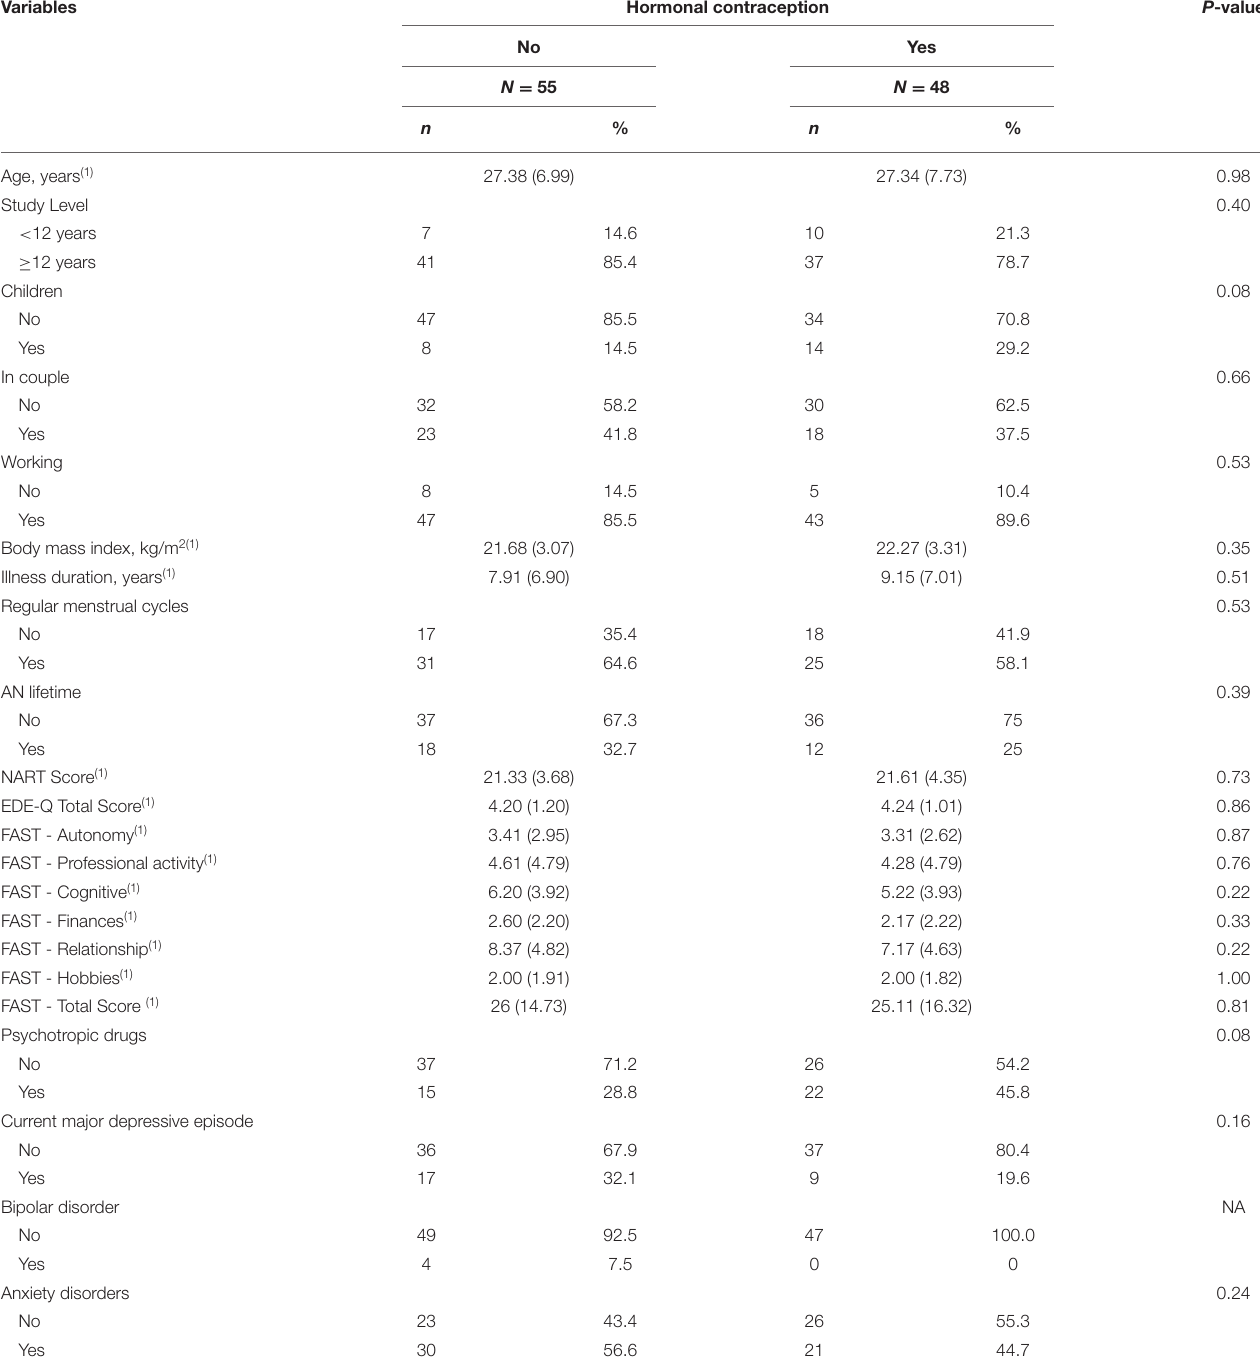
TABLE 1 | Association between hormonal contraception and sociodemographic and clinical data. Variables Hormonal